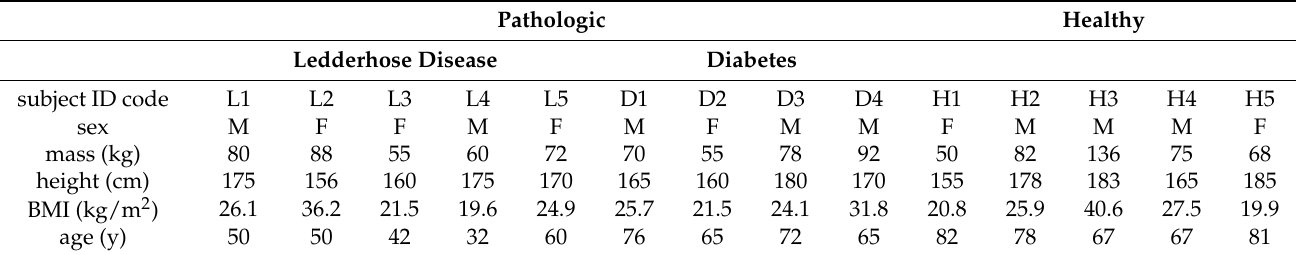
Table 1. Characteristics of the subjects involved in the study.